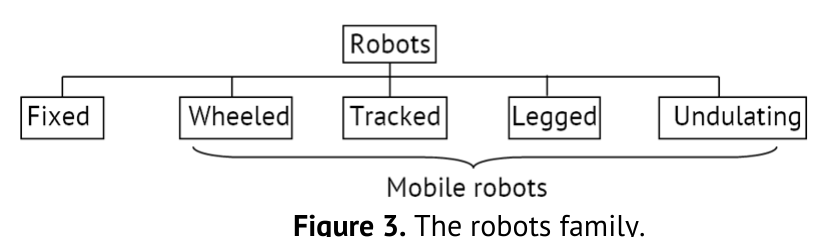
Figure 3. The robots